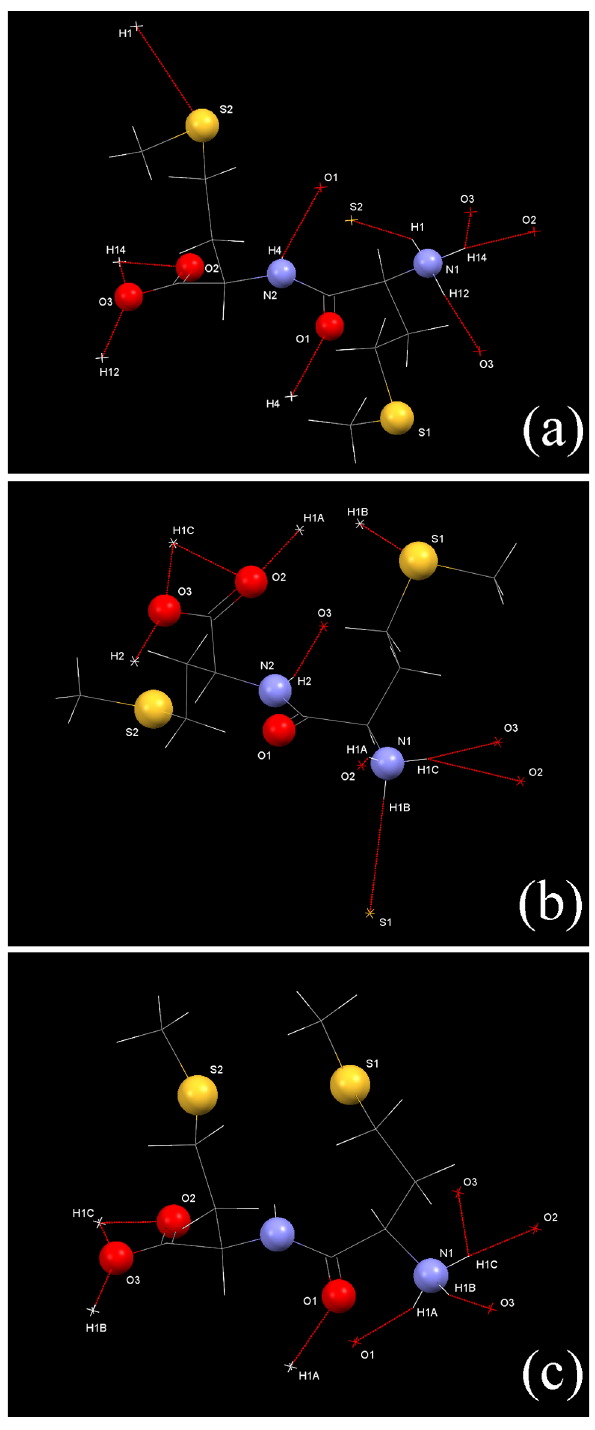
Figure 5. Hydrogen bonding (red dotted lines) around individual molecules in the crystal structures of: ( a ) ll, ( b ) dd–ll and ( c ) dl–ld